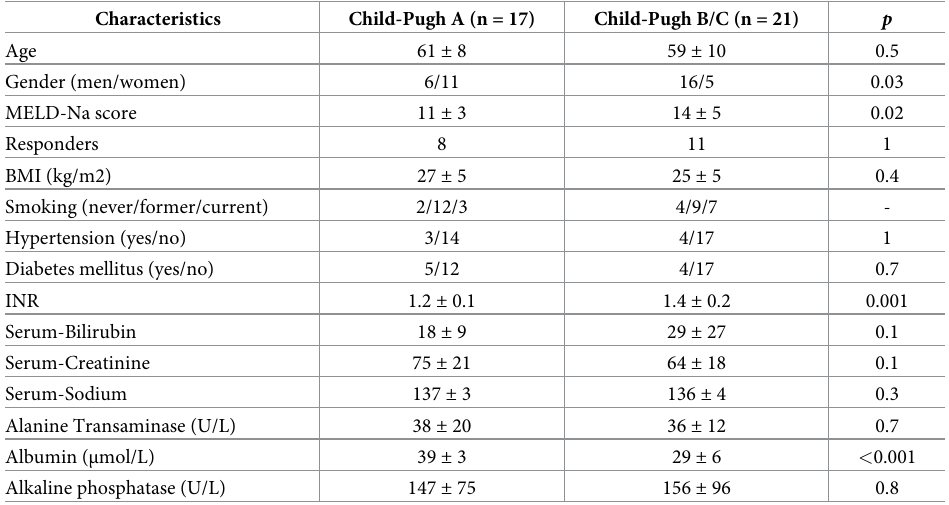
Table 1. Demographic, clinical, and biochemical characteristics of different Child Pugh groups.